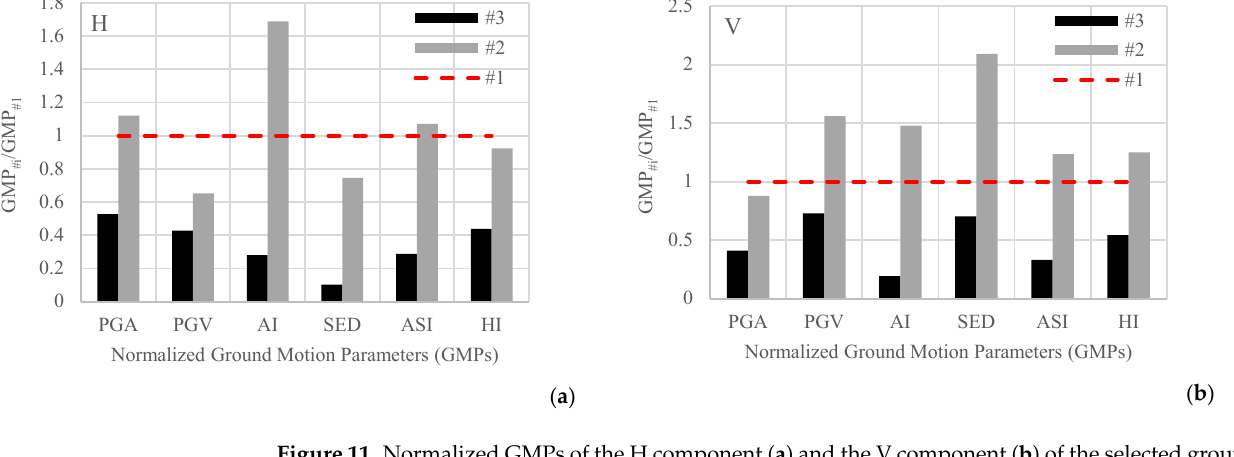
Figure 11. Normalized GMPs of the H component ( a ) and the V component ( b ) of the selected ground motion records.